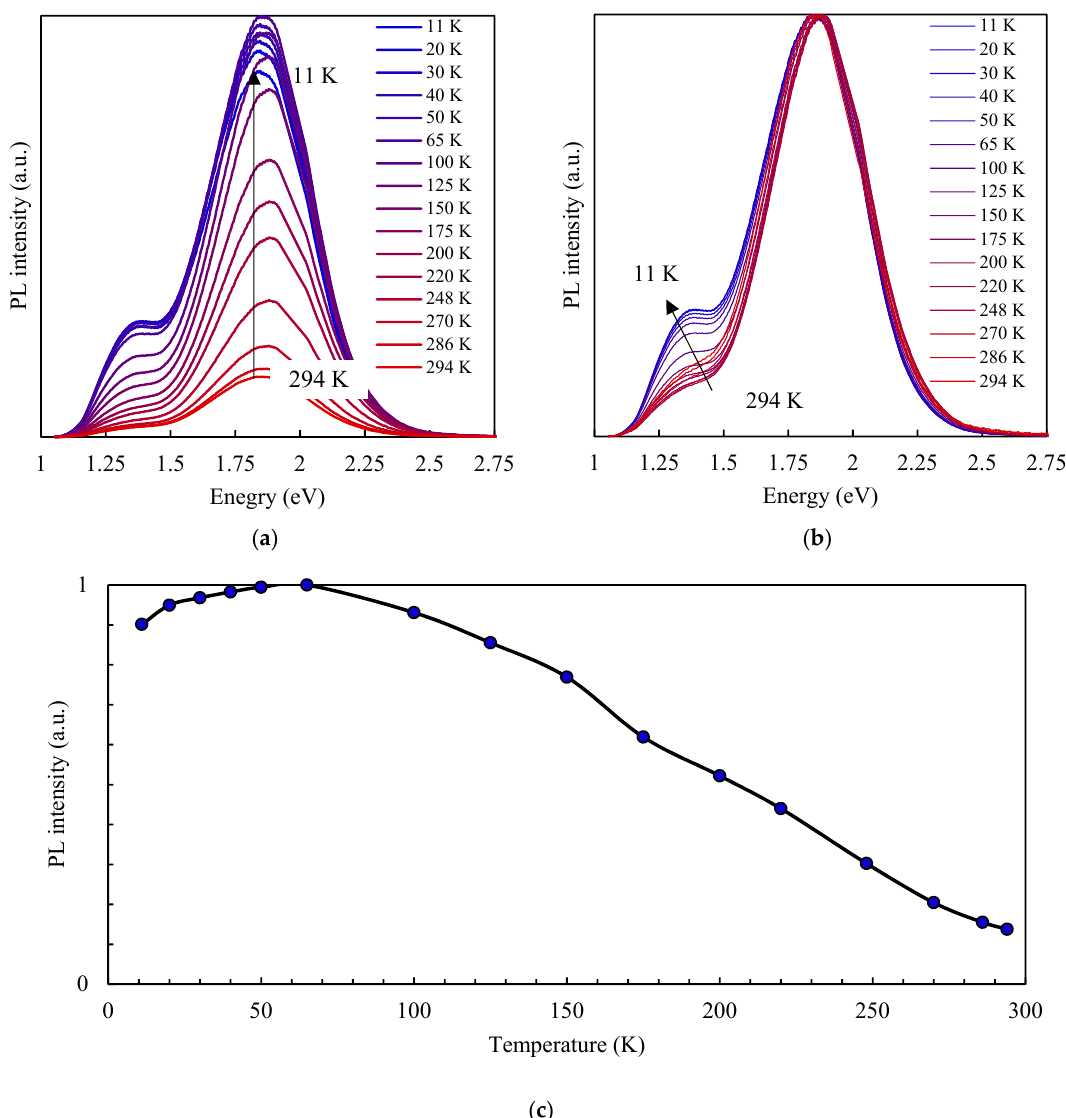
Figure 6. Temperature-dependent PL spectra ( a ), normalized temperature-dependent PL spectra ( b ), and temperature dependence of the PL integral intensity ( c ) of PVP-capped AgInS 2